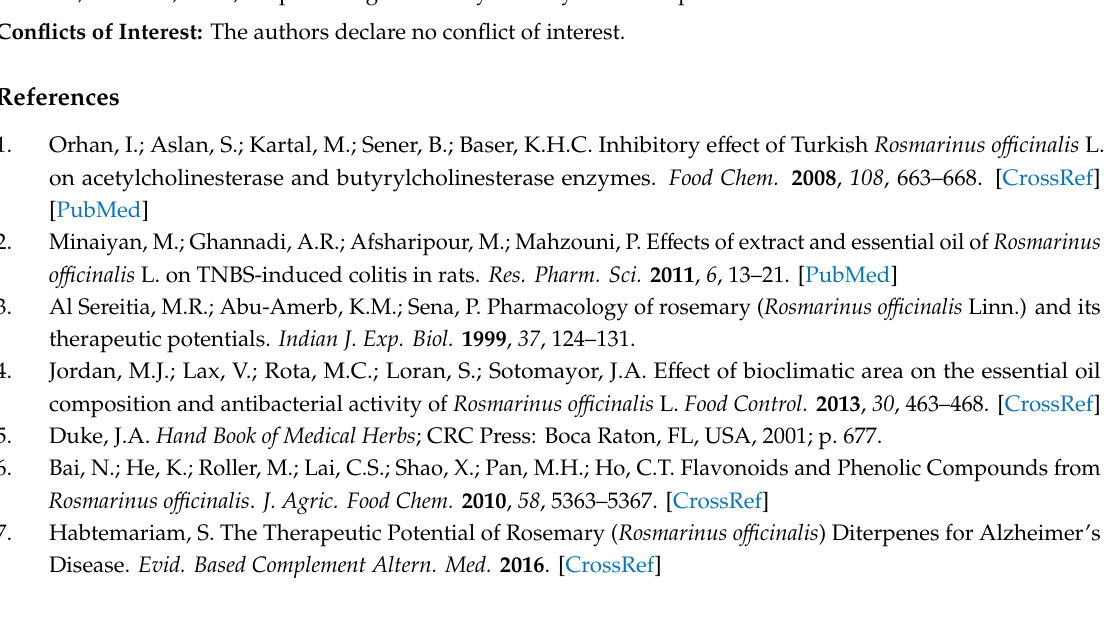
Supplementary Materials: Figure S1: QTOF-MS spectrum of ca ff eic acid, Figure S2: QTOF-MS spectrum of rosmarinic acid, Figure S3: QTOF-MS spectrum of luteolin-7- O -glucoside, Figure S4: QTOF-MS spectrum of carnosol, Figure S5: QTOF-MS spectrum of carnosic acid, Figure S6: QTOF-MS spectrum of ursolic